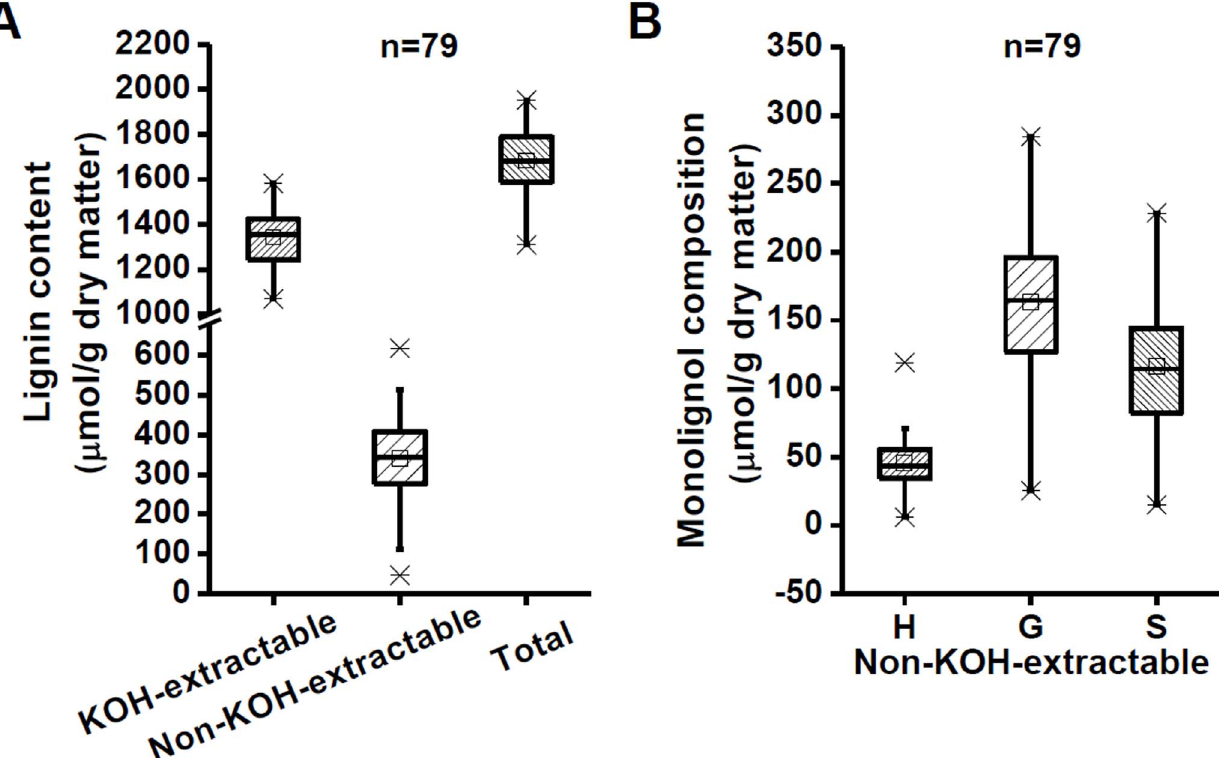
Figure 1. Variation of lignin content and monolignol composition in Miscanthus (n=79). (A) Lignin content; (B) Monolignol composition.